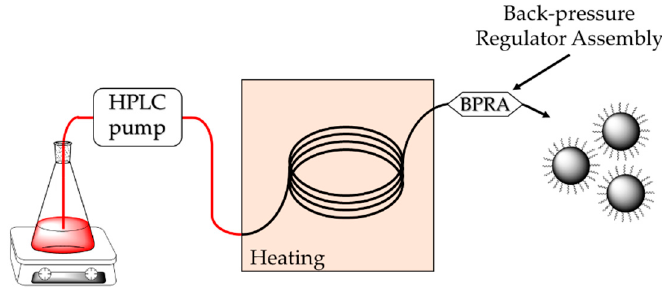
Figure 2. Schematic representation of the experimental setup used for the flow synthesis of VSION.